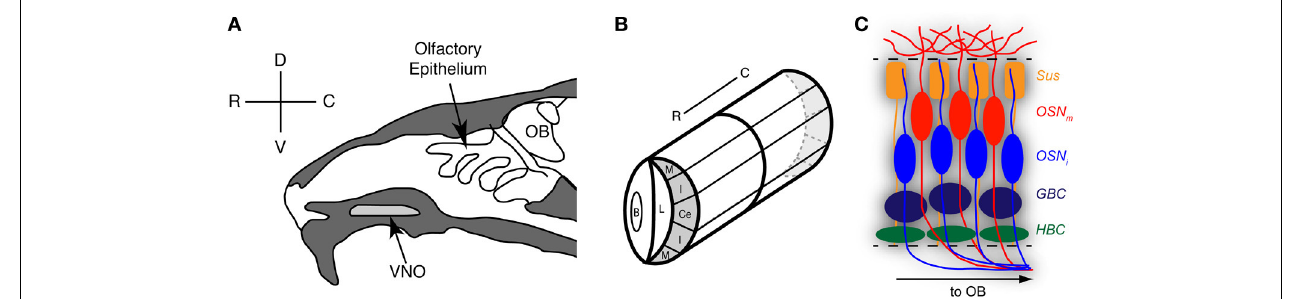
FIGURE 1 | Organization and zones of the mouse olfactory epithelium. (A) Sagittal schematic of the rodent nose depicting the locations of the olfactory epithelium and the vomeronasal organ (VNO). (B) The VNO is a bilaterally symmetrical tubular structure; shown here is one half of a coronal plane as it would appear through the depth of this structure. The marginal zones (M) are found at the extreme dorsal (D) and ventral (V) regions of the VNO. Adjacent to the marginal zones are the intermediate zones (I). In